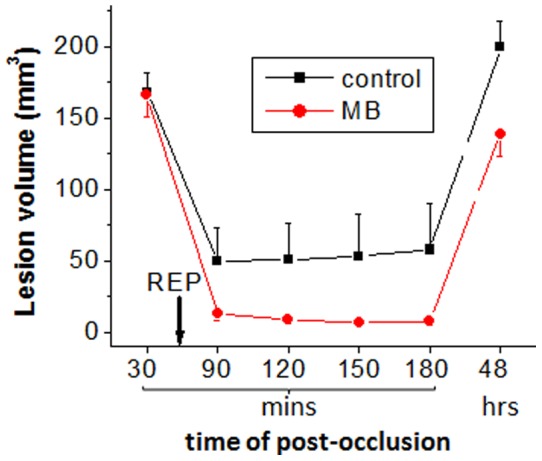
Evolution of the lesion volumes over time (determined using day-0 ADC maps and day-2 T2 maps) are demonstrated.